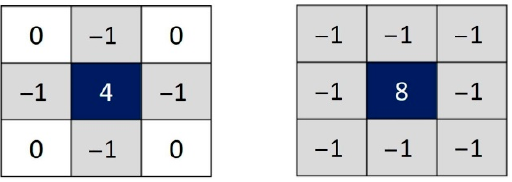
Figure 1. Two commonly used discrete approximations to the Laplacian